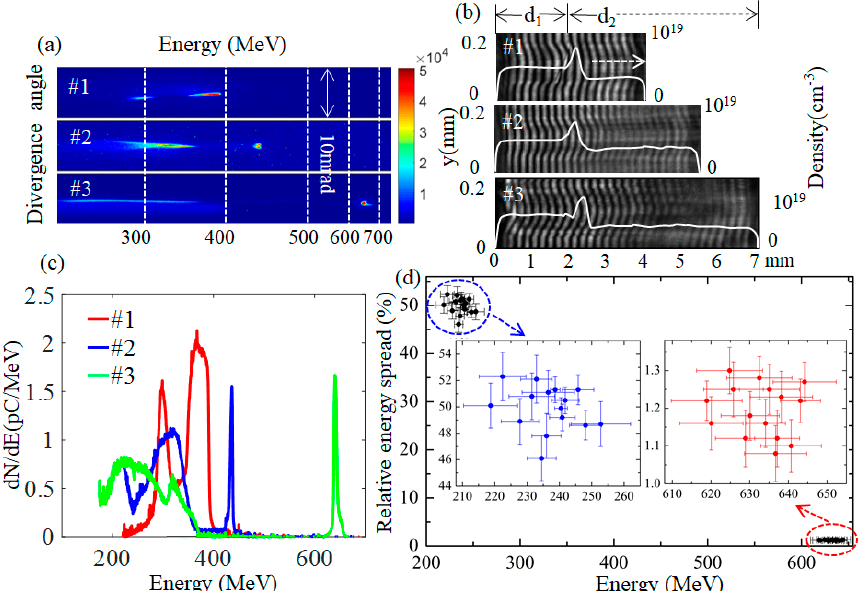
Figure 2. ( a ) Energy spectra of two-color e -beams. ( b ) Plasma channel with different plasma length of 4.0, 5.5, and 7.0 mm. ( c ) Corresponding e -beam angle-resolved energy spectra. ( d ) Statistics of shot-to-shot fluctuations of the energy of the e -beams and full width at half maximum (FWHM) energy spread when the plasma length was 7.0 mm.